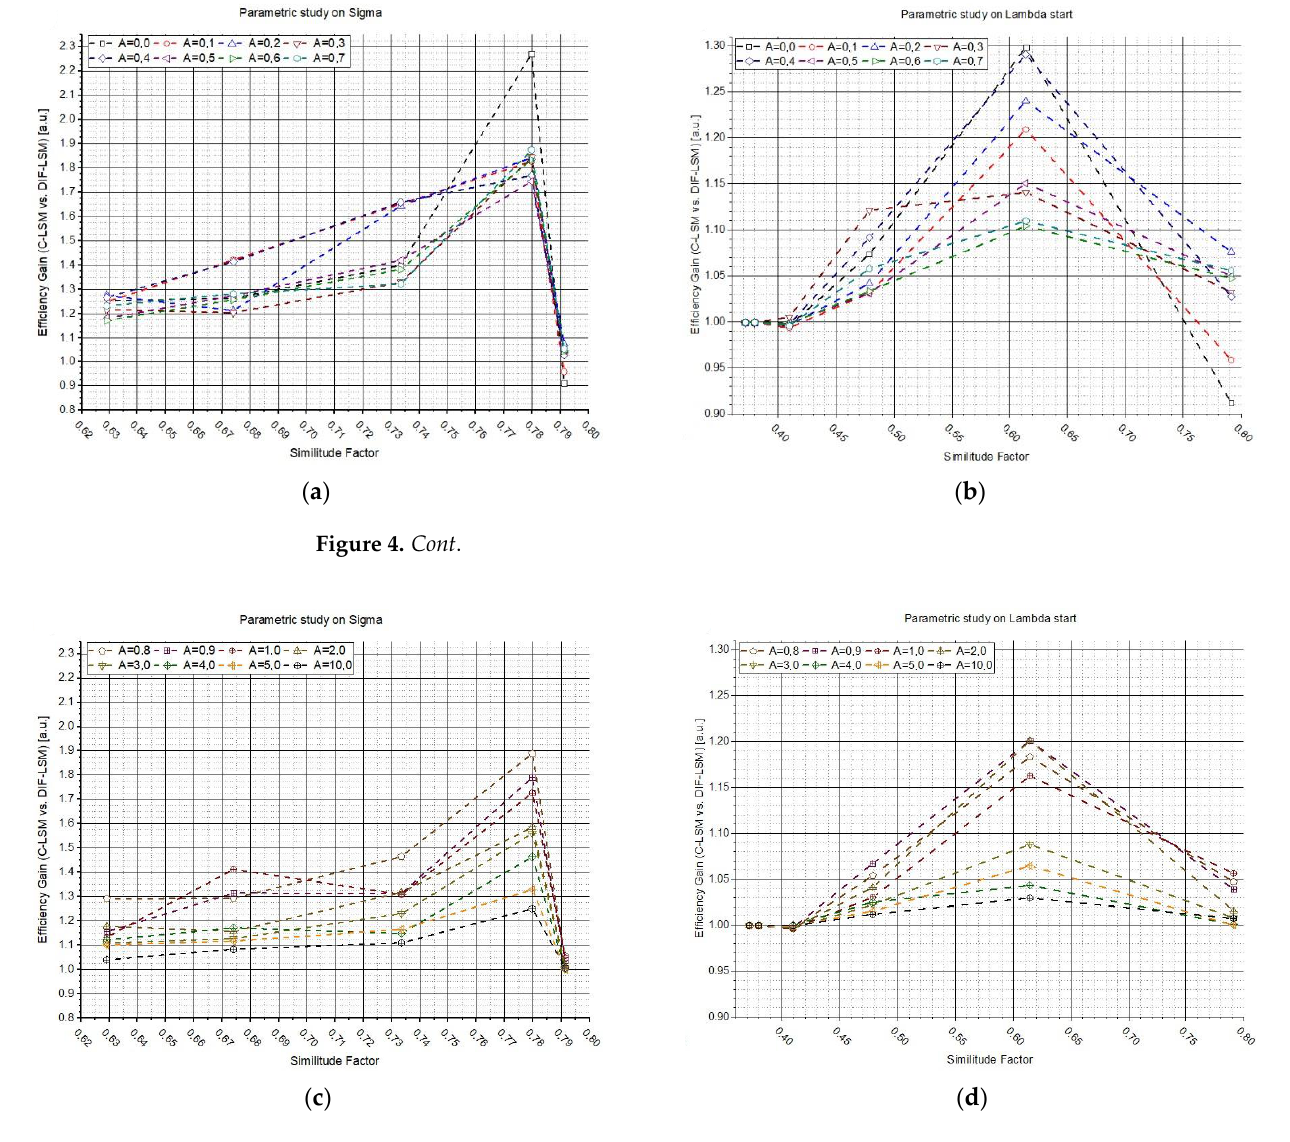
Figure 5. Influence of concentration differences on the efficiency gain (P) between the two algo- rithms. The plot describes the parametric study on concentration variations and its effect on the accuracy of the W DIF -LSM algorithm as a function of the parameter A variation, using for every test the same couple of synthetic spectra. Finally, summarizing the results, it is possible to understand the importance of using the arbitrary parameter A to obtain better results from the W DIF -LSM algorithm. In